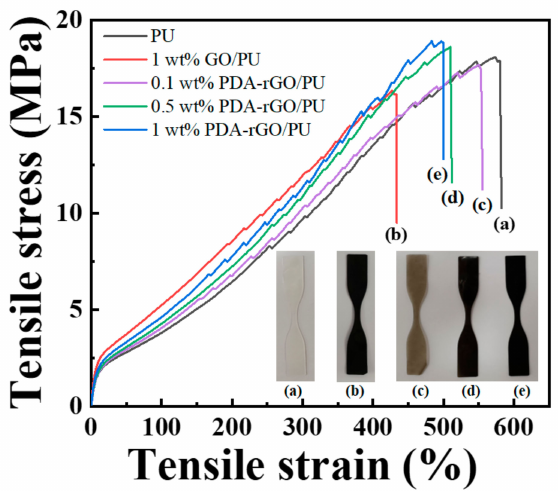
Figure 6. Strain–stress curves of ( a ) neat PU, ( b ) 1 wt% GO/PU, ( c ) 0.1 wt% PDA–rGO/PU, ( d ) 0.5 wt% PDA–rGO/PU, and ( e ) 1 wt% PDA–rGO/PU nanocomposites.